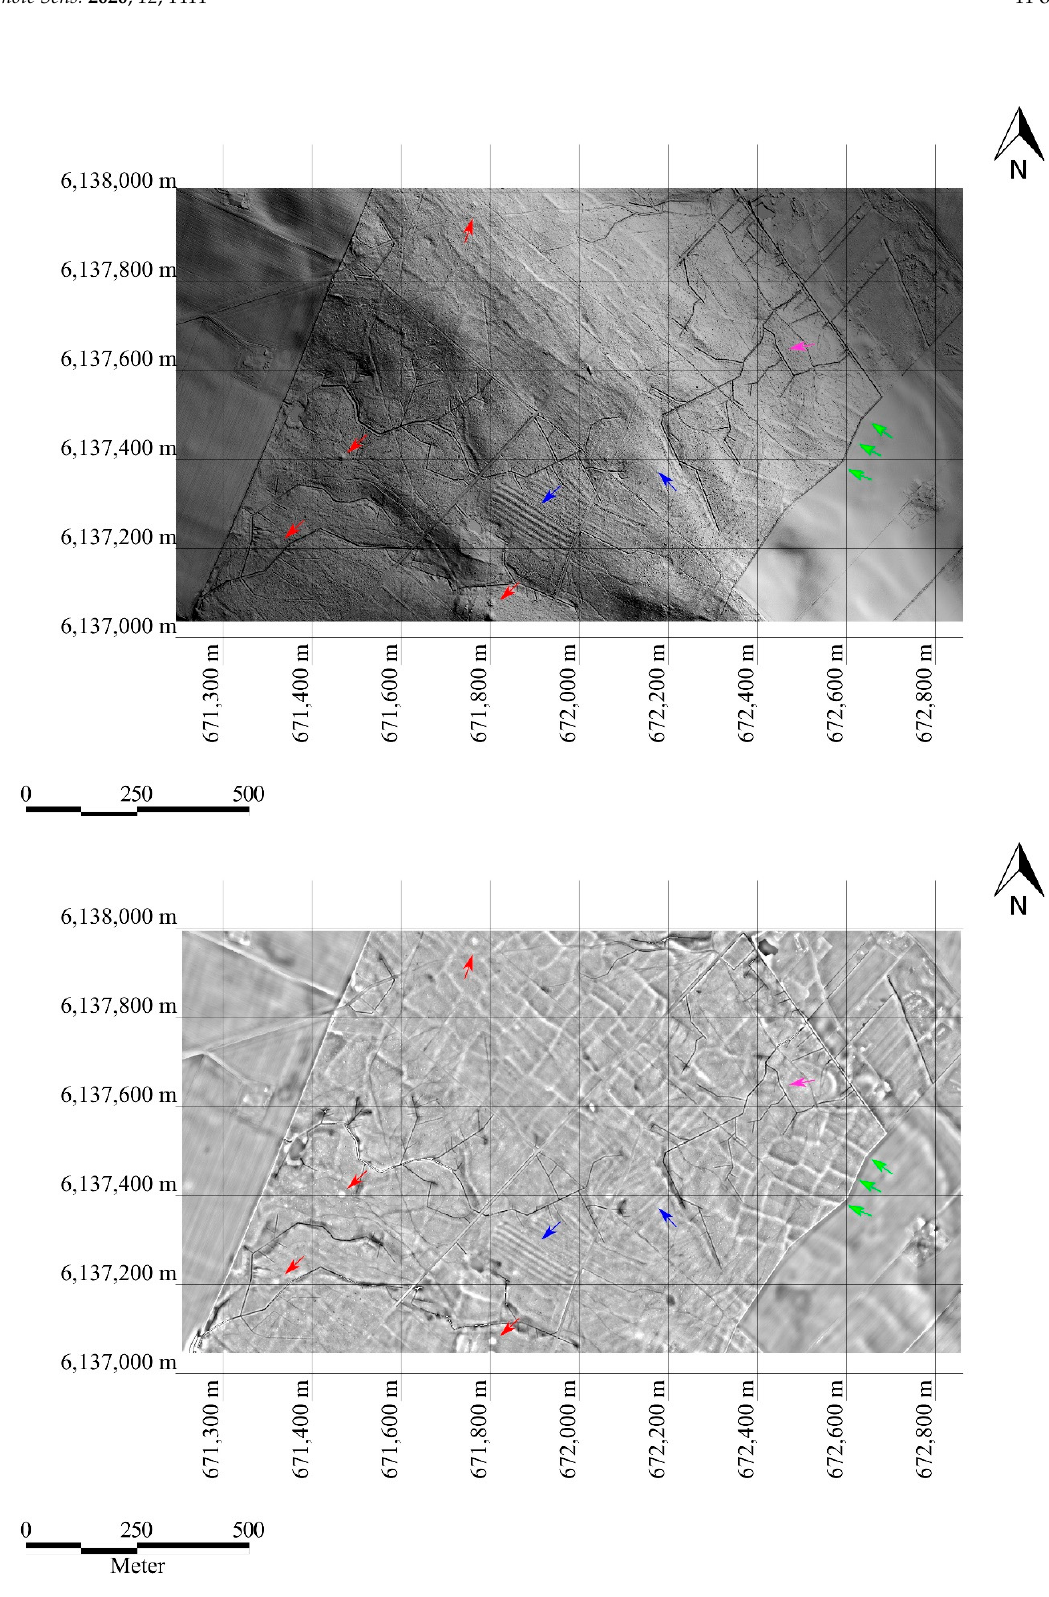
Figure 4. Upper image ( A ): An example, shown as a hillshade, of the Danish 2015 national airborne laser scanning (ALS) study. The Glumsø Østerskov forest, Næstved municipality, covers archaeological features such as Neolithic megaliths, a Celtic field system, and traces of Medieval ridge-and-furrow cultivation, all superimposed by modern drainage ditches. As the Celtic fields are situated on both sides of a ridge the hillshade visualization is not optimal, as some areas are over- or underexposed, regardless of the direction of light. Lower image ( B ): Same as above but pictured